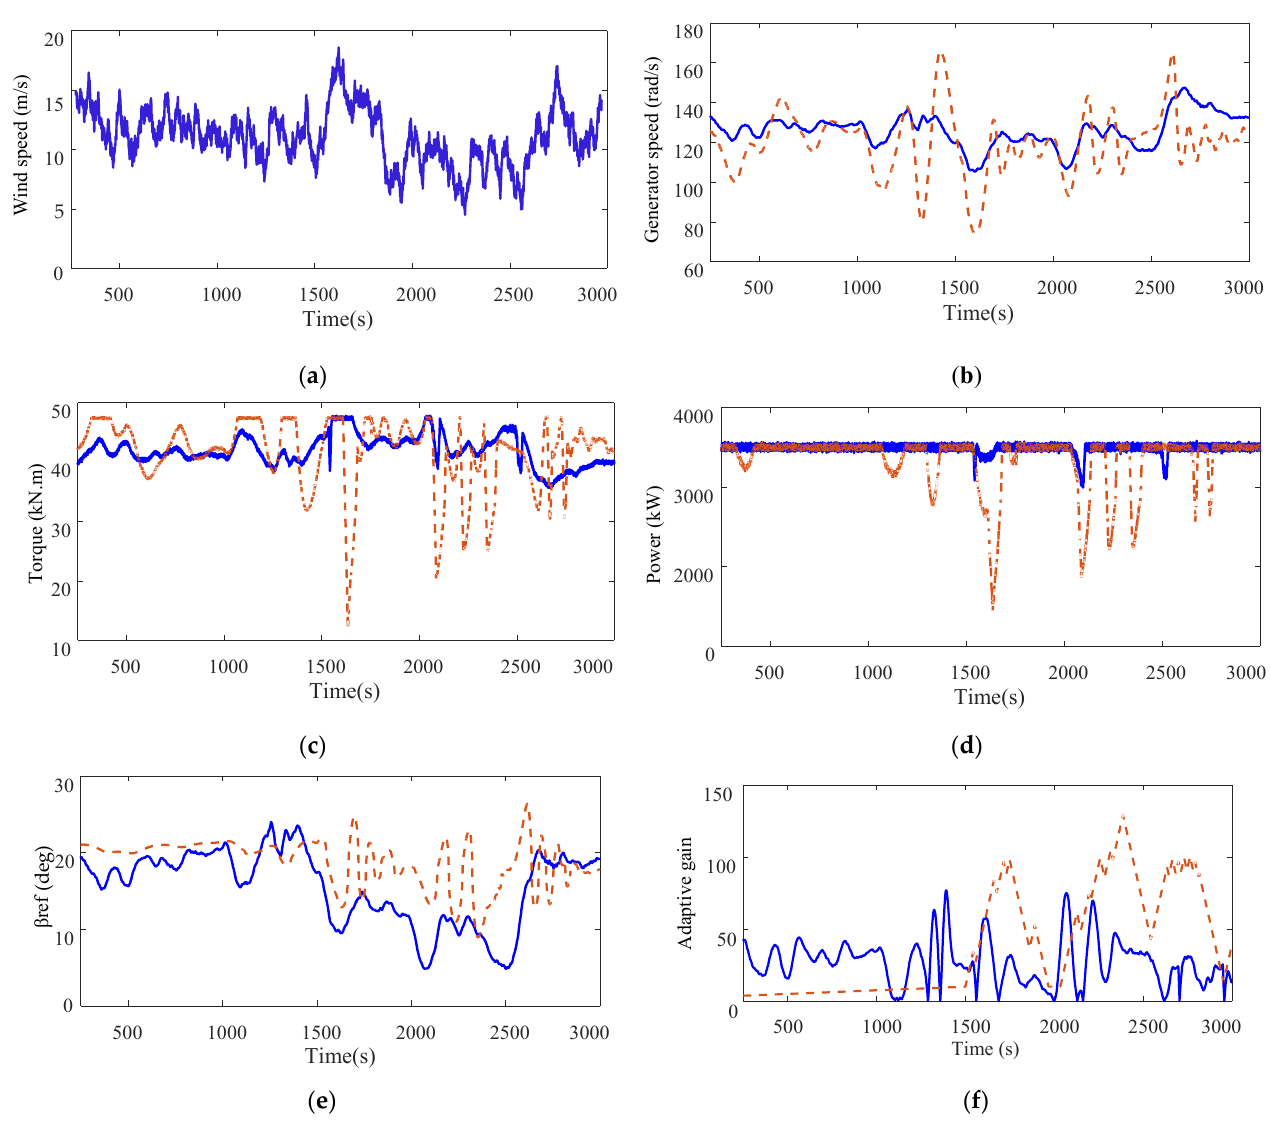
Figure 3. Dynamics of the wind turbine system (proposed approach, approach in [33]): ( a ) Hub height wind speed profile; ( b ) Generator speed; ( c ) Torque; ( d ) Generator power; ( e ) Pitch angle; ( f ) Adaptive gain.